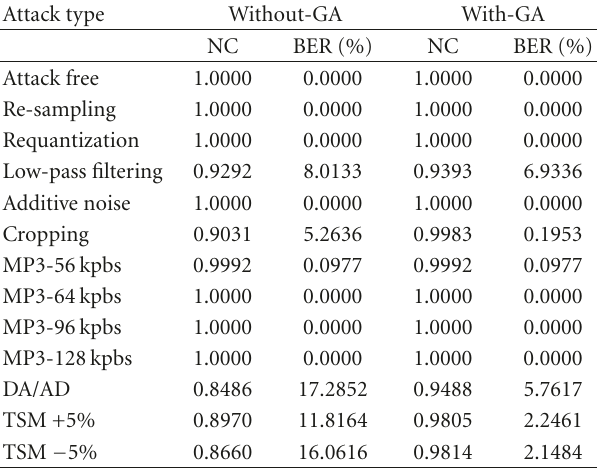
Table 5: Robustness comparison of our algorithm (average